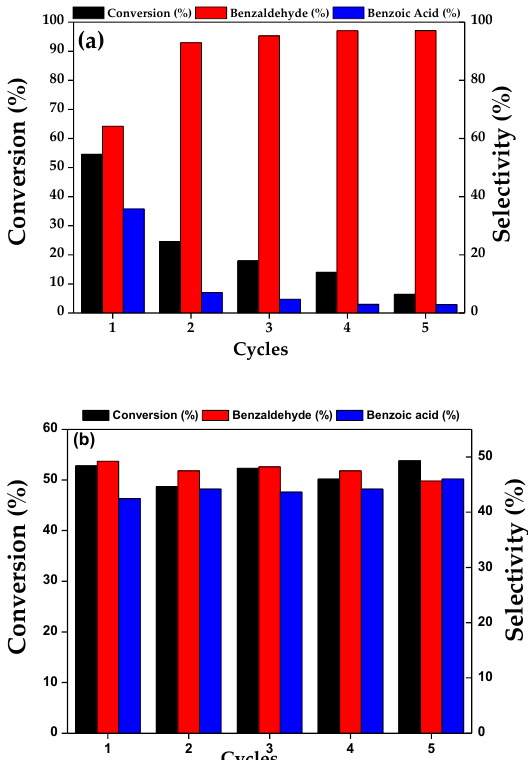
Figure 5. Recycling tests for the Au/calc-Sr sup catalyst in benzyl alcohol oxidation under ( a ) base-free conditions and ( b ) K 2 CO 3 extra-base